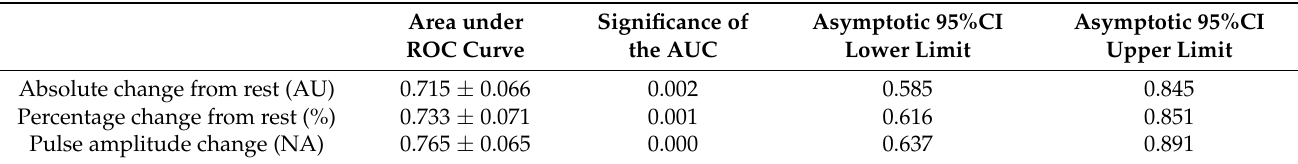
Table 1. Area under the receiver operating characteristics (ROC) curve (AUC) to determine the presence of a compression at imaging. AUC values are not significantly different between the three